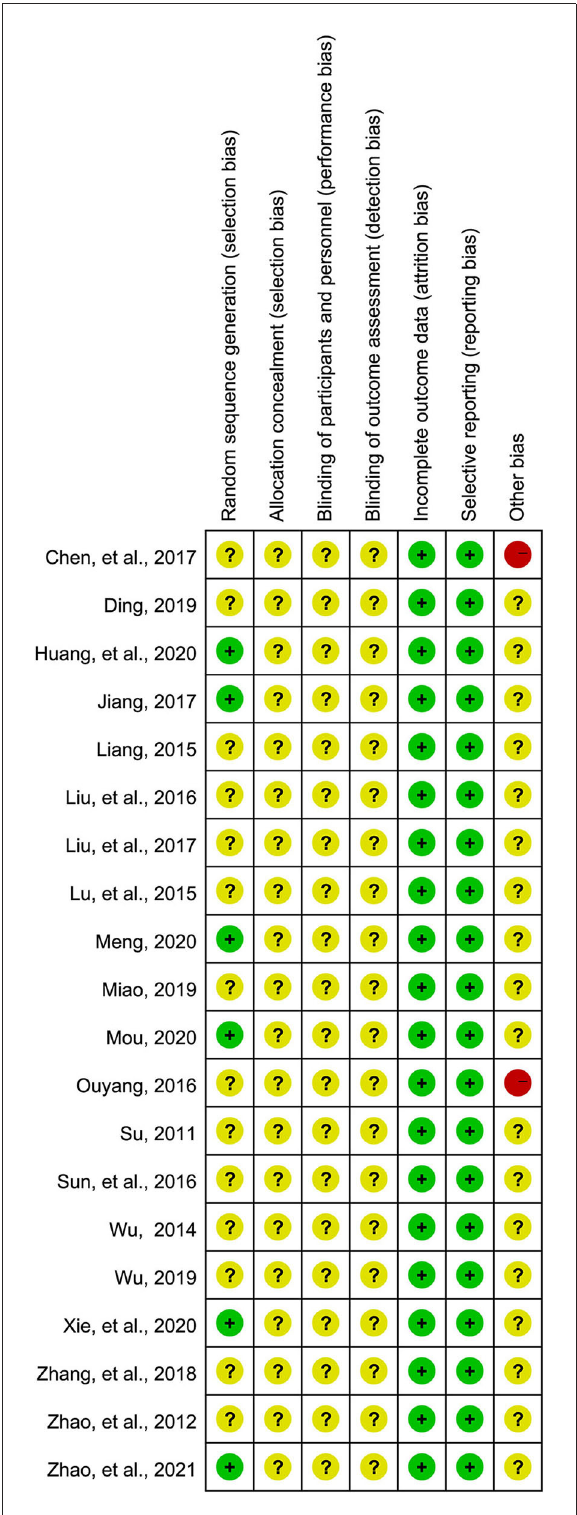
FIGURE2 Risk of bias summary. Three colors including green, yellow, and red were used to represent the level of risk, which was corresponding to low, unclear, and high risk,